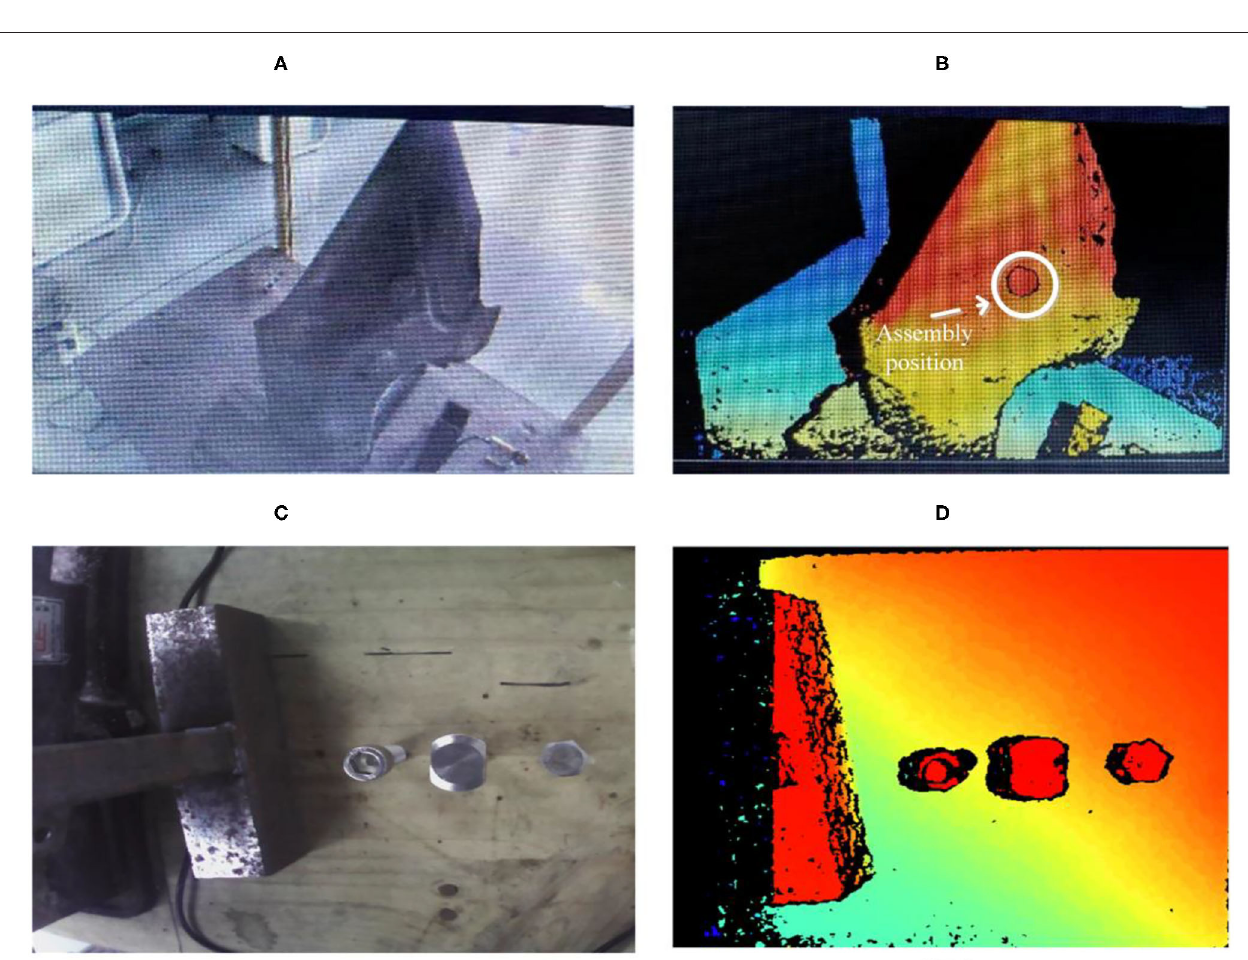
FIGURE 9 | Modeling of the assembly environment. (A,B) Are the actual picture and 3D point cloud picture of truck parts respectively. (C,D) Are the actual picture and 3D point cloud picture of screws respectively.